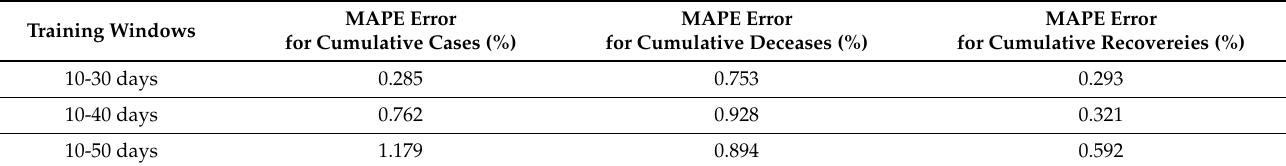
Table 4. MAPE errors for Greater São Paulo region as the size of the training window